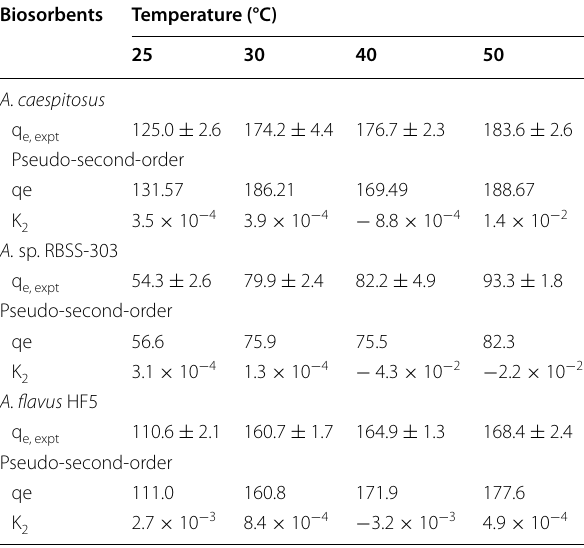
Table 5 Evaluation of pseudo-second-order and satu- ration mixed order kinetic models, rate